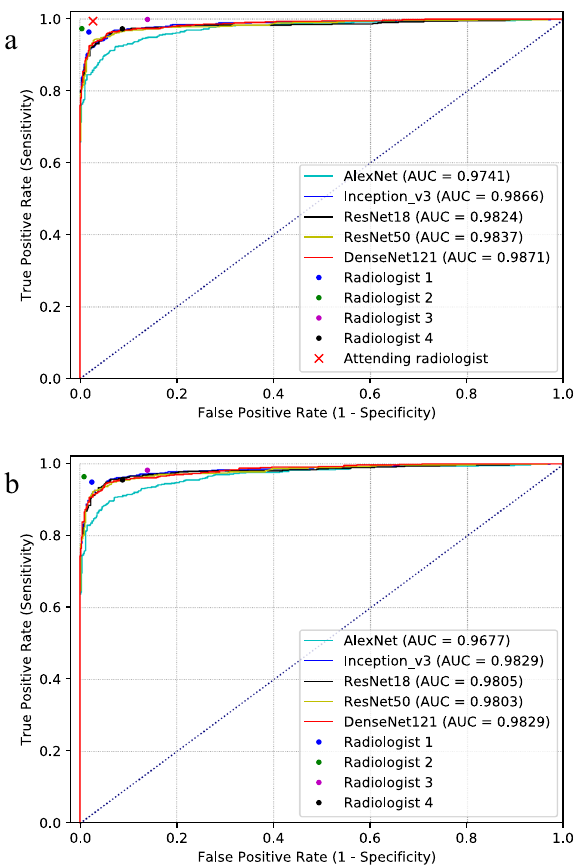
Fig. 1 Receiver operating characteristic curves (ROCs) for differ- ent ImageNet pre-trained CNN architectures versus radiologists on the NIH “ ChestX-ray 14 ” dataset. a Labels voted by the majority of radiologists as the ground-truth reference standard. b Labels derived from text reports as the ground-truth reference standard. Radiologists ’ performance levels are represented as single points (or a cross for attending radiologist who wrote the radiology report). AUC area under the different. Figure 1 shows the ROC curves of selected CNN models evaluated with reference labels from radiologist consensus (shown in sub fi gure a) and the attending radiologist (sub fi gure b).